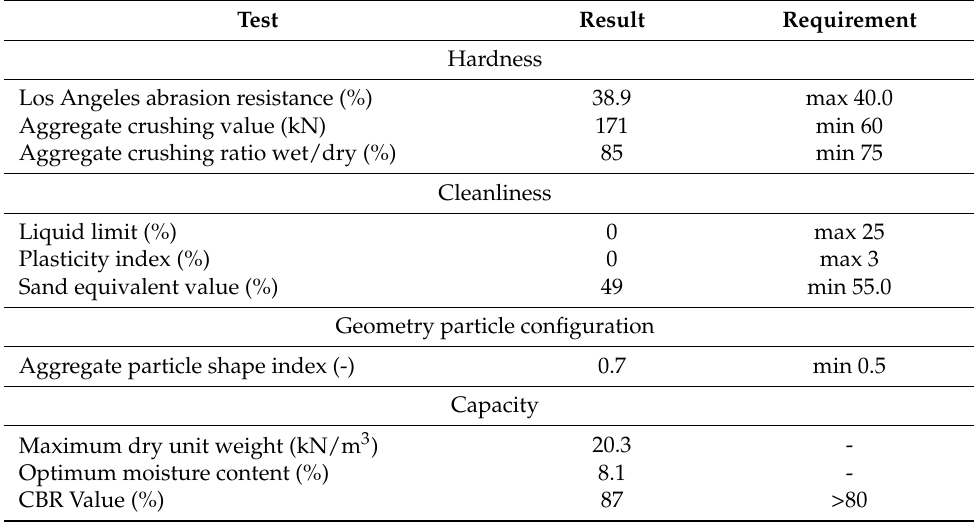
Figure 5. Base Granular material size distribution. Table 3. Granular material properties.